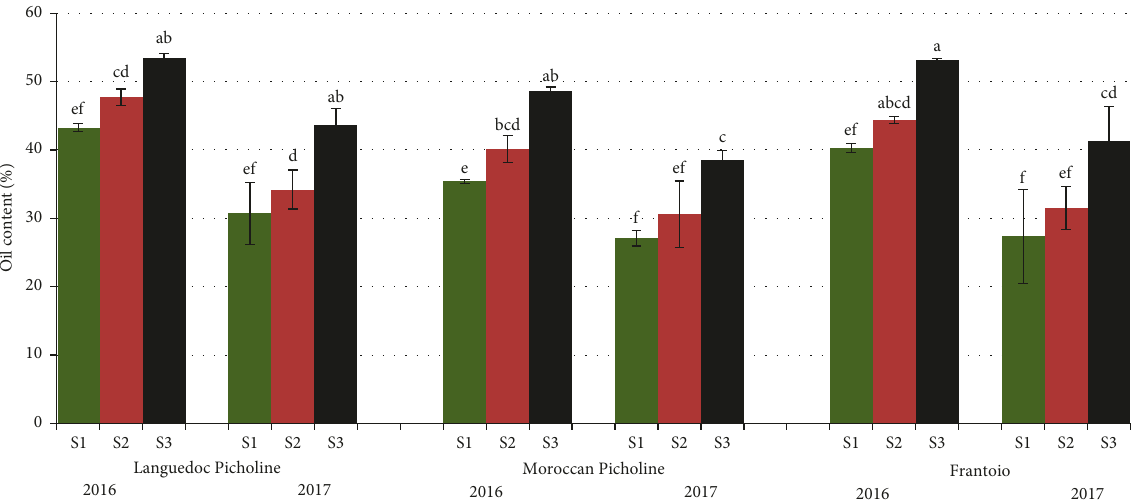
Figure 4: Oil contents (% DW) of different olive cultivars grown in the Marrakech region (Morocco) at different stages of maturity (S1: green; S2: purple; S3: black). Values are means ± standard deviation (SD) of three replications. Data followed by different letters are significantly different from each other ( P < 0 . 05) according to the LSD